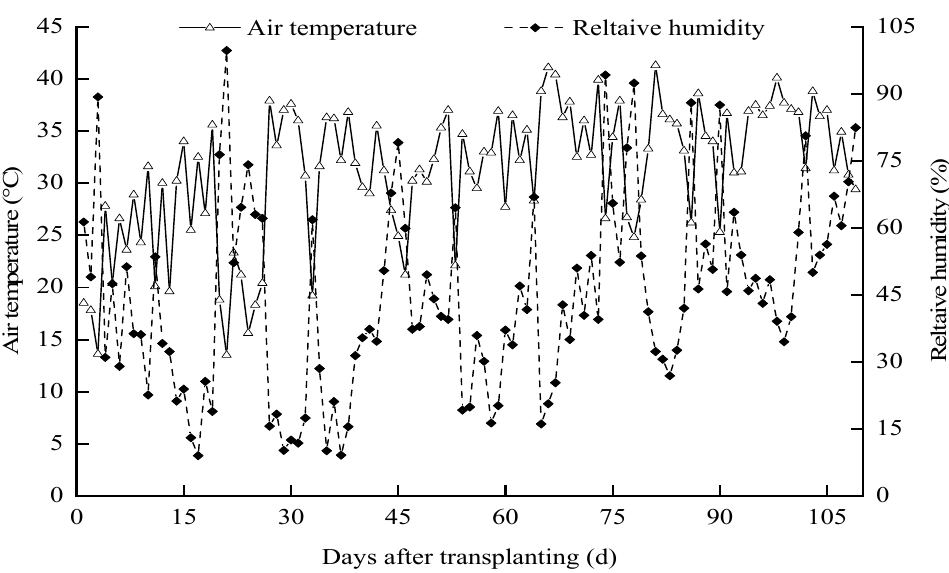
Figure 1. Dynamics of the air relative humidity and temperature during the cropping season.